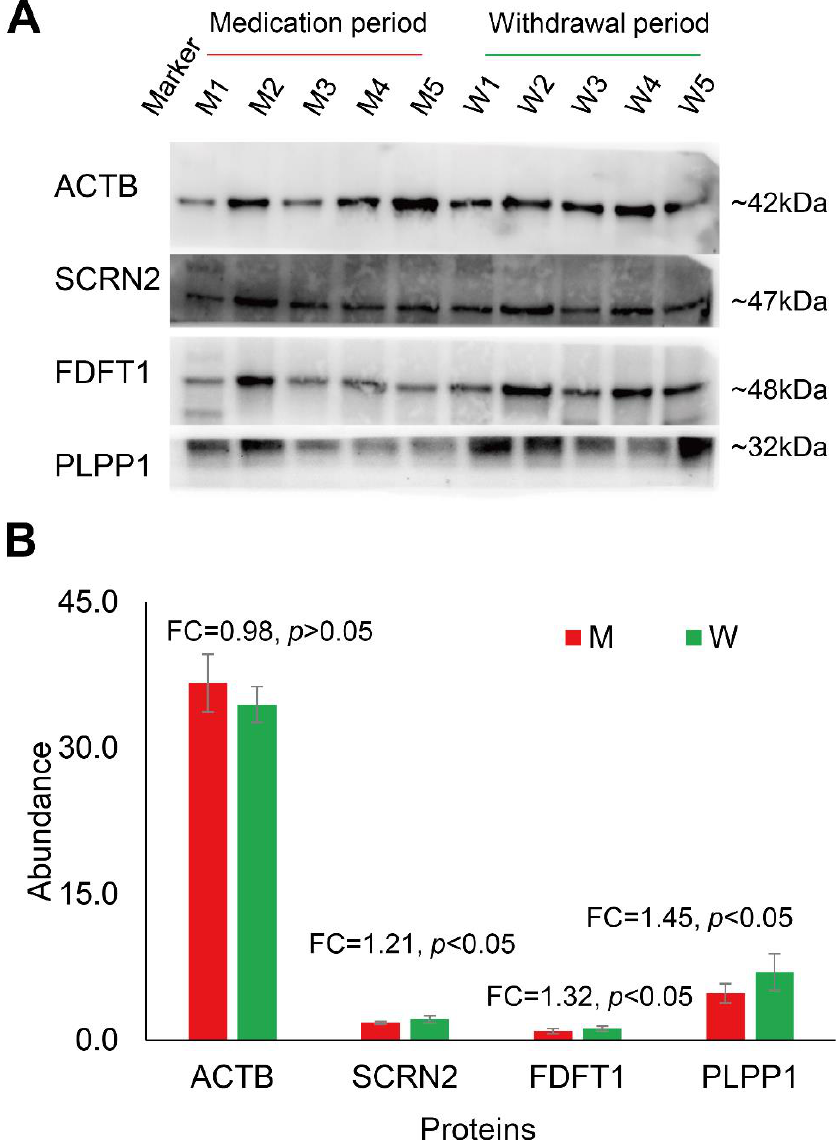
Figure 6. Western blot validation ( A ) and LC-MS/MS quantification ( B ) of four representative sperm proteins.